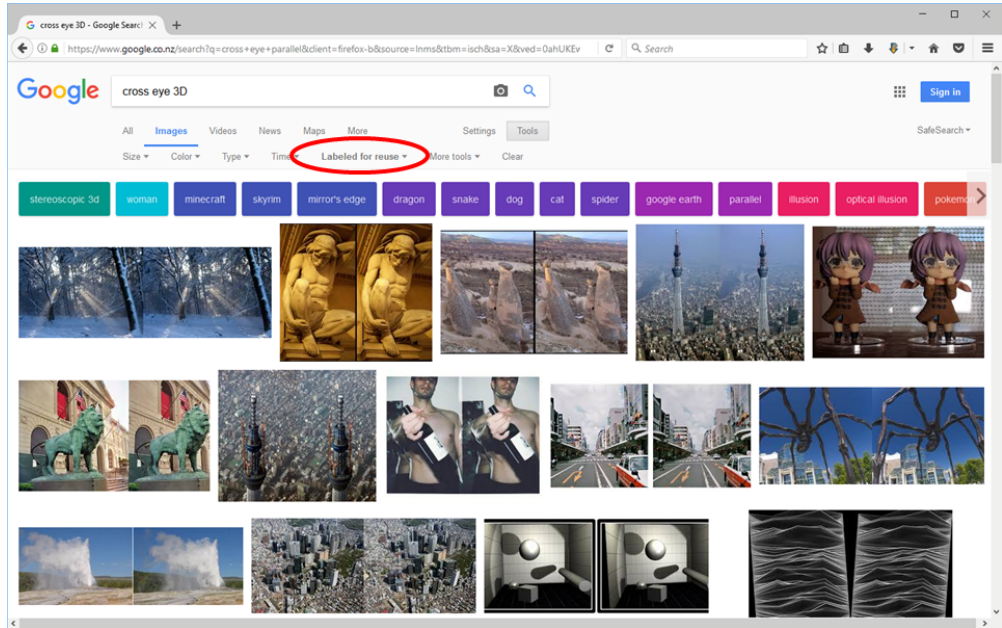
Figure 3. Publicly available images returned from keyword “cross eye 3D” on Google